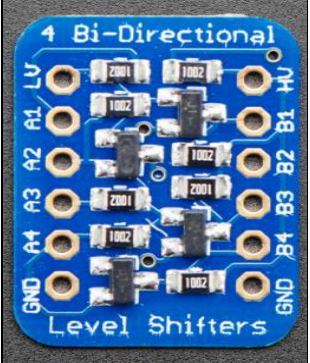
Figure 10: Bidirectional voltage converter. Source: Taken from [36].